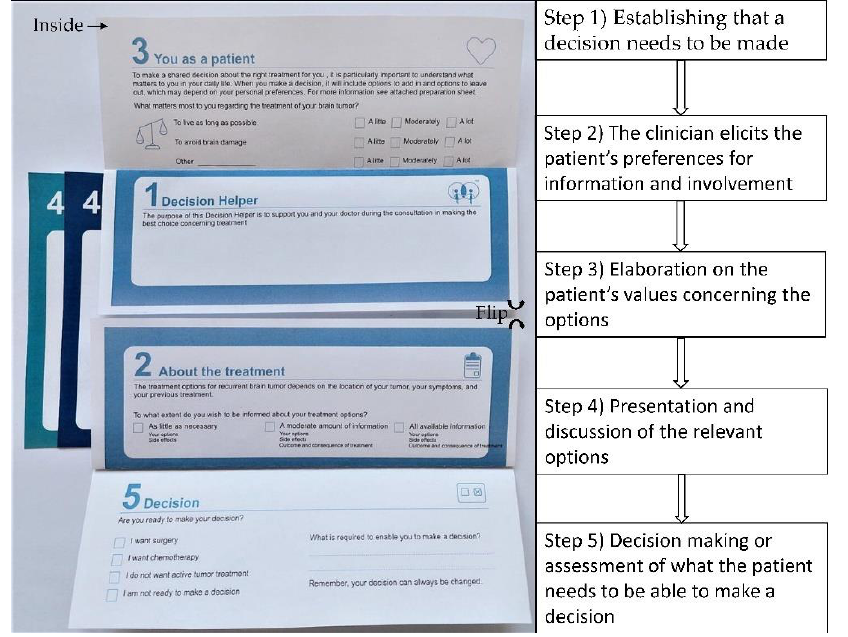
Figure 1. The in-consult patient decision aid and a description of the five steps in the decision-making process.